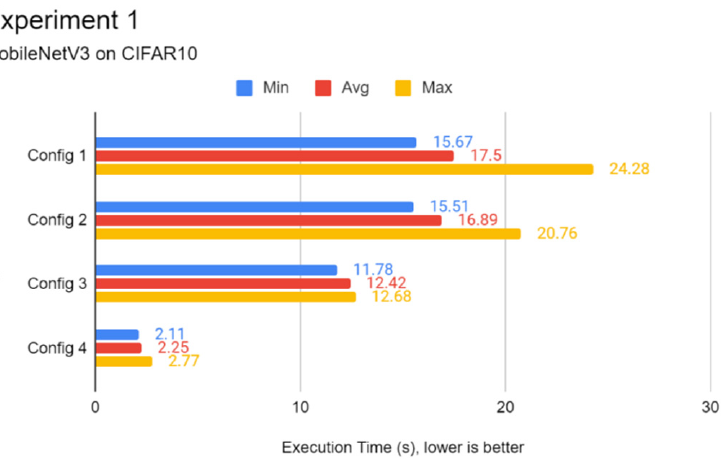
Figure A4. Bar chart execution time results for all systems running MobileNetV3 on CIFAR10 in Experiment 1. Configurations 2 and 3 are excluded due to Spark OOM error.